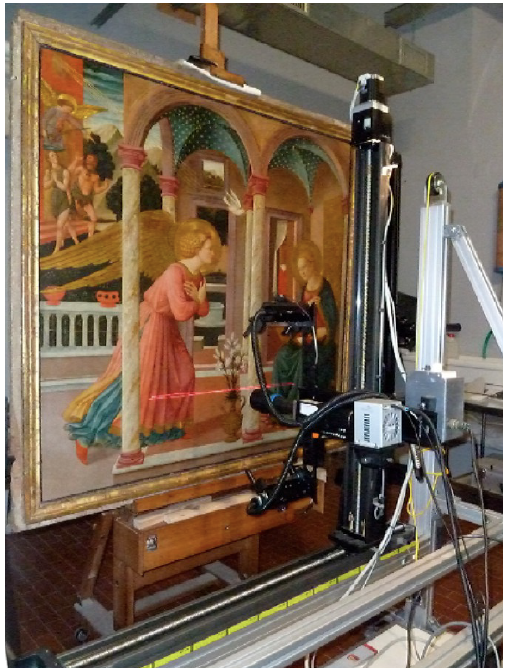
Figure 1. L’Istituto di Fisica Applicata “Nello Carrara” (IFAC-CNR), Florence, Italy, reflectance hyperspectral imaging system (400 to 1700 nm). Reprinted (adapted) with permission from [27]. Copyright 2016 American Chemical